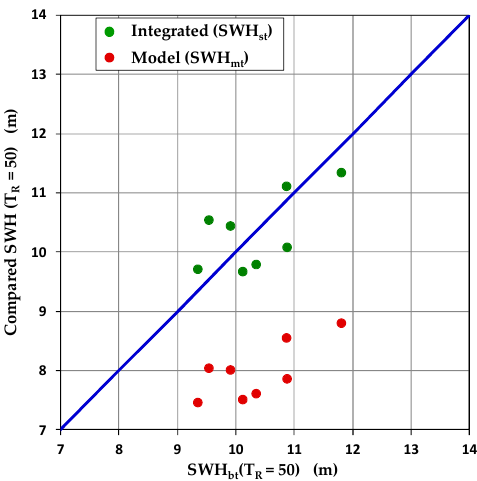
Figure 4. Pacific Coast error analysis for T R = 50 years: SWH(T R ) values computed through model data (red circles) and integrated procedure (green circles) are compared with SWH(T R ) values computed through buoy data (solid blue line). R 2 between SWH st and the identity line 0.0076.